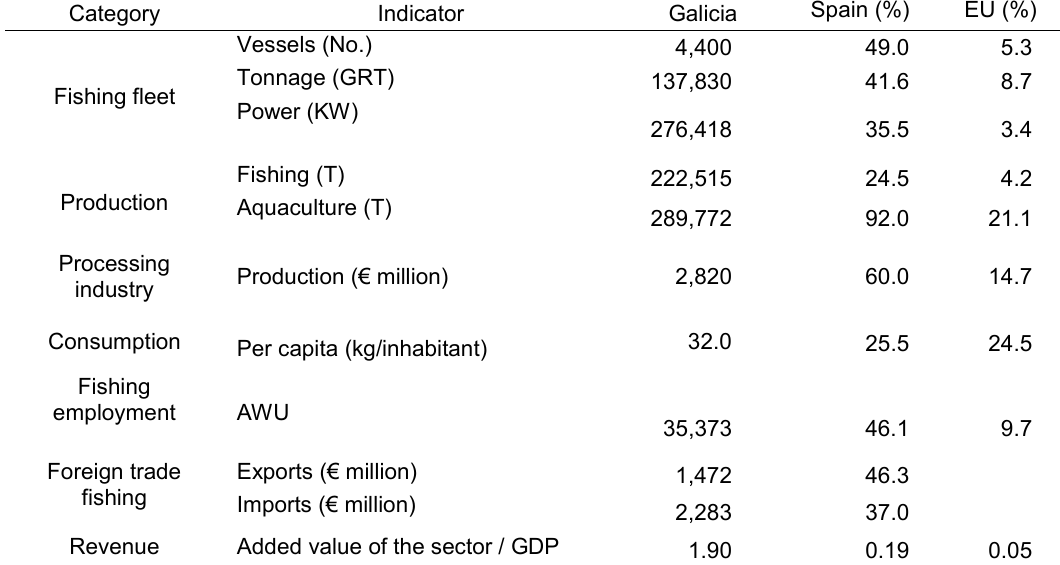
Table 1 . The Galician fishing industry in figures